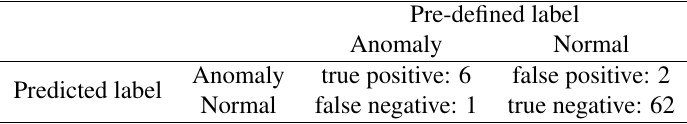
Table 4: The detected counts in confusion matrix for the tuning